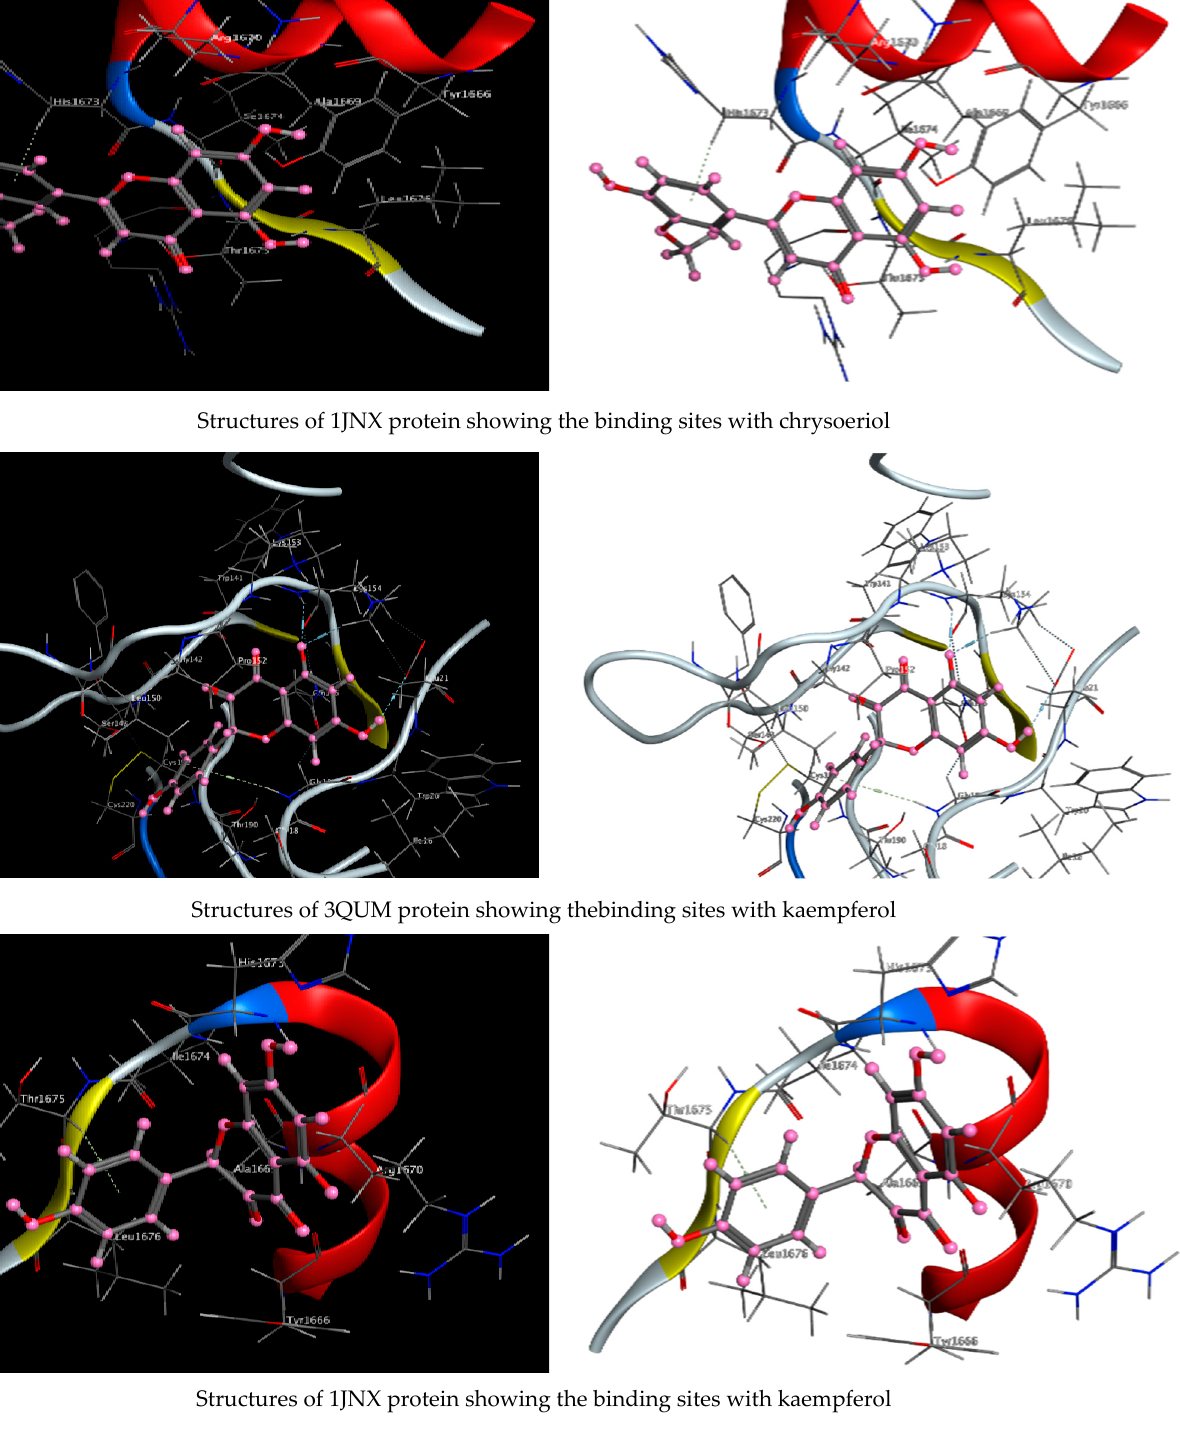
Figure 11. Structures of different proteins showing their respective binding sites for active compounds.